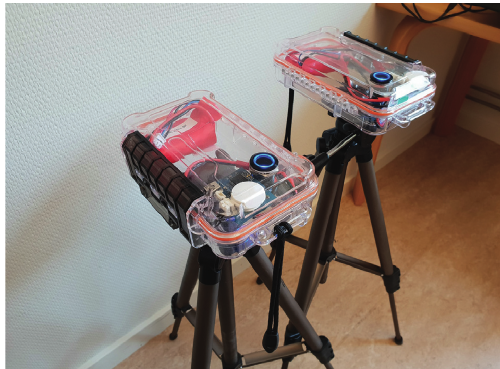
Figure 5: Our UWB modules mounted on tripods, each in a waterproof enclosure together with a battery. These are used as stationary